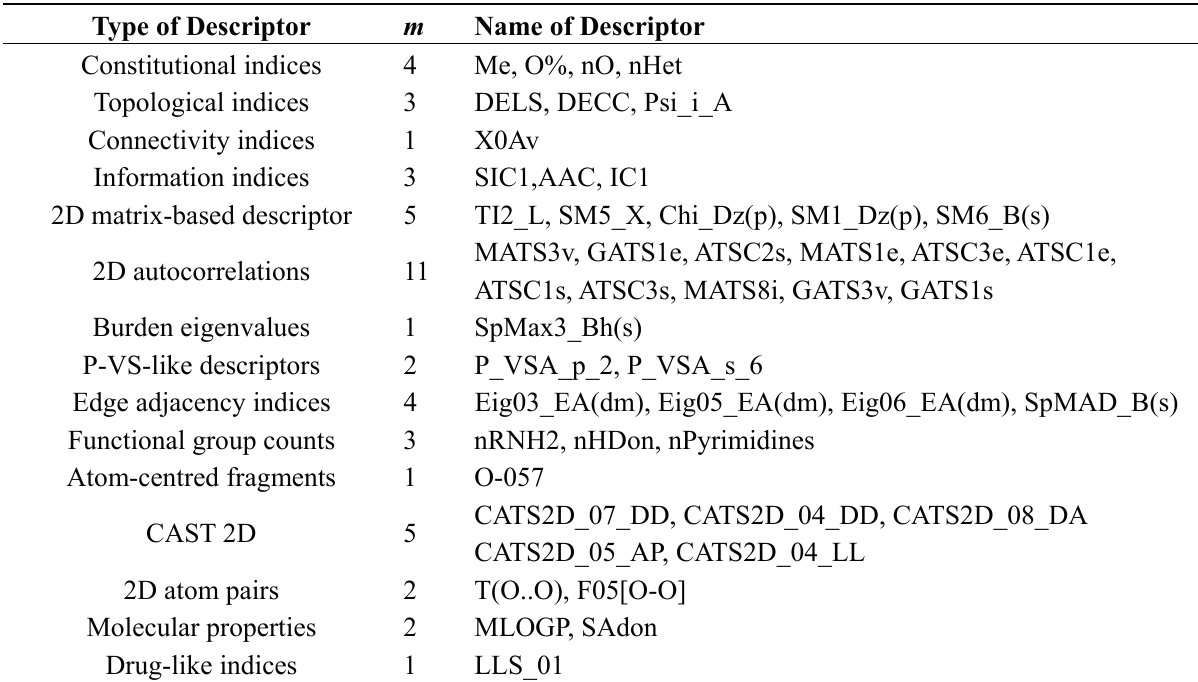
Table 2. The names and types of selected 48 optimal